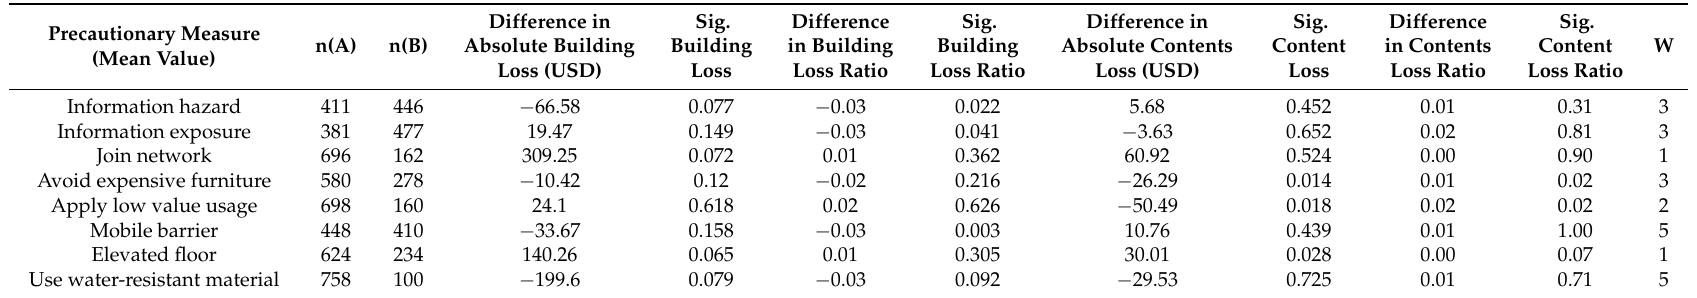
Table 6. Weight of precautionary measures (n is the total number of cases; w is the weight for the indicator of the difference in losses; n(A) is the number of houses that did not apply measures; n(B) is the number of houses that applied measure; the difference in losses expresses the loss reduction between Group B and Group A; sig. is significance probability or p -value; a positive value means that the measure has no reduction in losses; a negative value means that the measure has a reduction in losses; the significance expresses the correlation coefficient between losses and